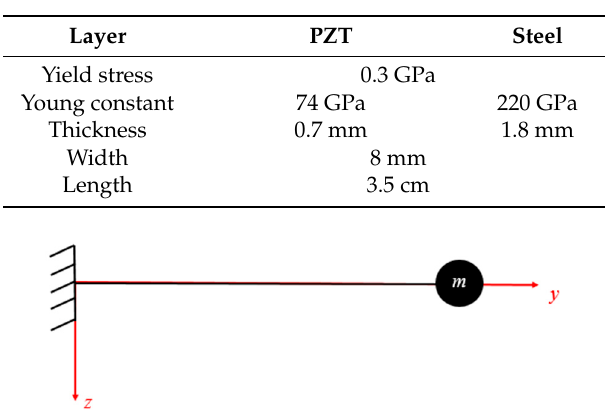
Table 4. Composite support-beam geometric and mechanic properties.